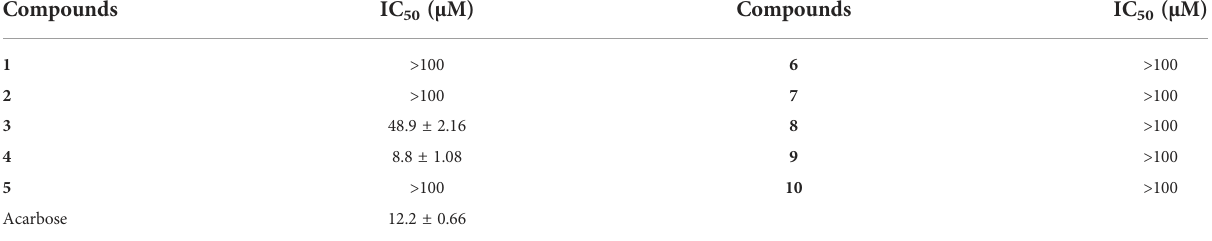
TABLE 3 a -glucosidase inhibitory activities.